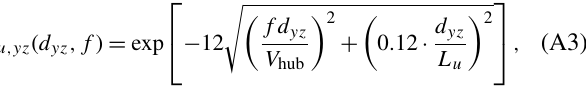
(cid:113) σ 2 u + σ 2 v + σ 2 w . L u is the integral length scale